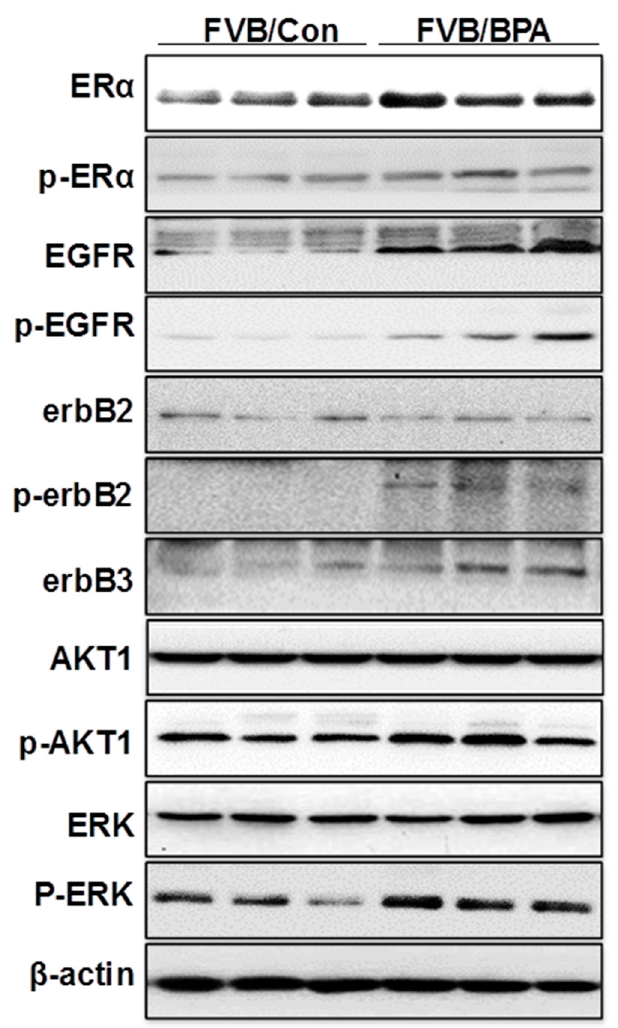
Figure 6. In utero exposure to low dose BPA induces ER-RTK crosstalk in mammary tissues of FVB / N mice. Pregnant FVB / N mice were treated with vehicle (FVB / Con) or 500 ng / kg BW of BPA (FVB / BP) via subcutaneous injection, daily between GD 11 and 19. The lysate was prepared from the mammary tissues of female o ff spring at PND 70, followed by Western blot analysis. Total and phosphorylated protein levels of indicated key regulators in ER and EGFR / erbB2 signaling pathways were